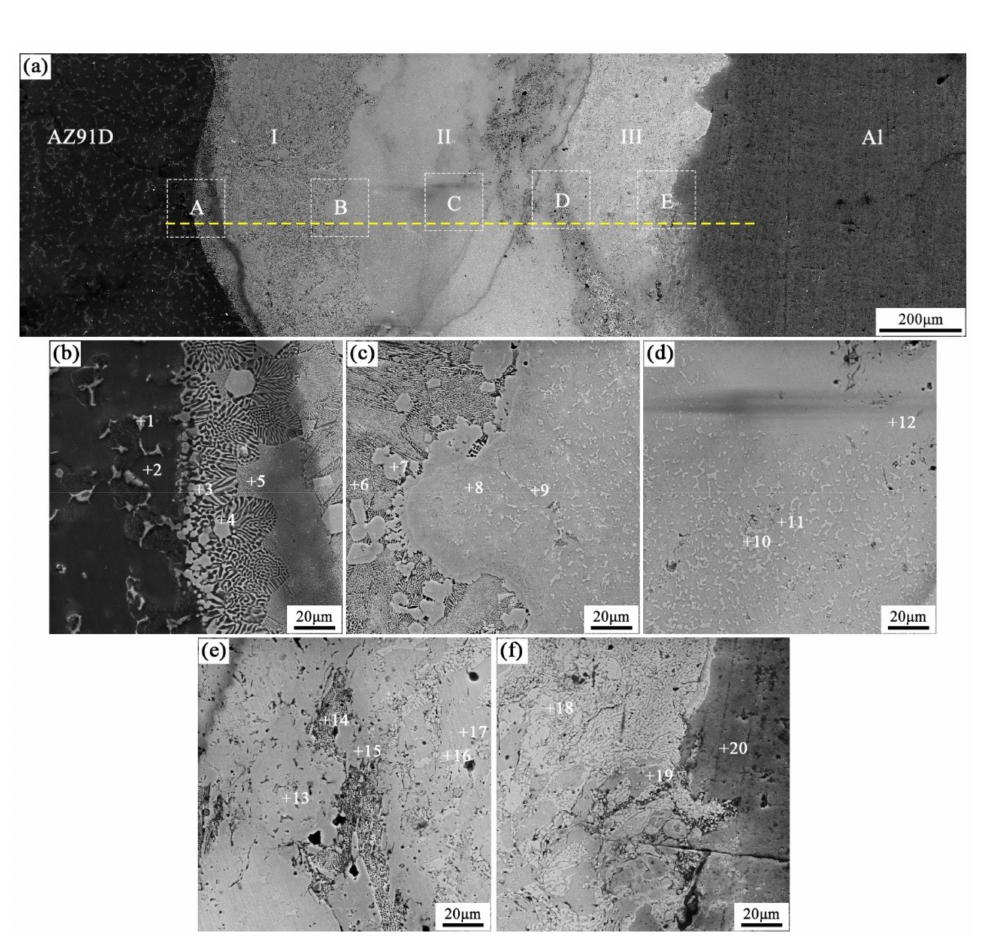
Figure 7. SEM micrographs of the interface in arc-sprayed Al / AZ91D with a Zn interlayer (arc-spraying Zn for 30 s and Al / Zn double-deck coating preheated for 6 h): ( a ) general view, ( b – f ) areas A, B, C, D, and E in ( a ),